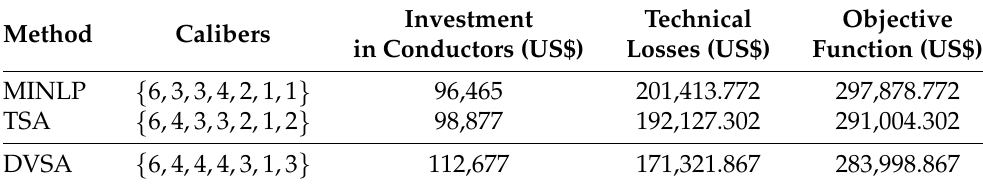
Table 21. Comparative results in the 8-bus system for the balanced load case for S